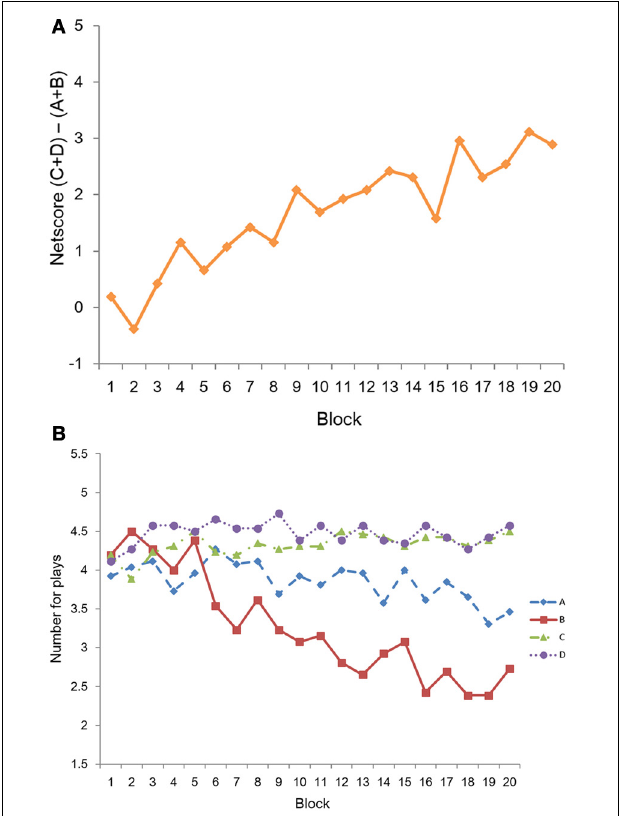
FIGURE 2 | Behavioral performance in the IGT. (A) Net score in each block. (B) The number of plays in each block for each deck.